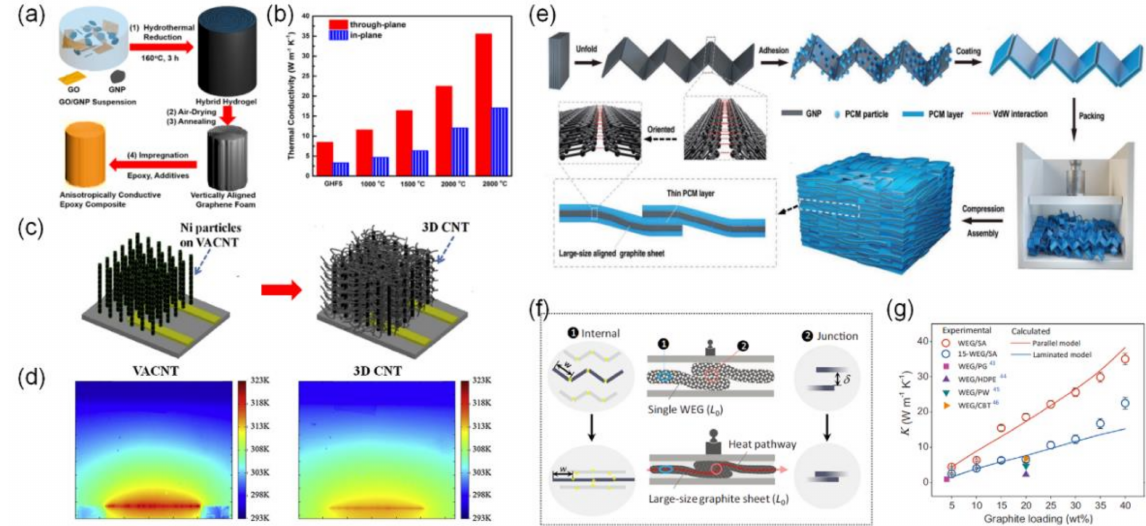
Figure 4. ( a ) Schematic illustration of the preparation of 3D graphene hydrogel composites and ( b ) the thermal conductivity of the composites after treatment at different annealing temperatures [23]. Copyright the American Chemical Society. ( c ) Preparation procedure of the secondary CNTs and ( d ) thermal maps of the VACNT and 3D CNT [24]. Copyright Elsevier. ( e ) Schematic diagram for synthesizing phase change composites. ( f ) The configuration diagram of the compressed worm-like expanded graphite (WEG). The red circles represent the thermal resistance junctions between the adjacent WEG (or graphite sheets). The blue ellipses represent the partial WEG (or graphite sheets). The red arrows represent the heat flow. The yellow, semitransparent solid circles represent the connections between GNPs. ( g ) Thermal conductivity of the WEG/SA and 15-WEG/SA composite blocks as a function of the graphite loading [25]. Copyright